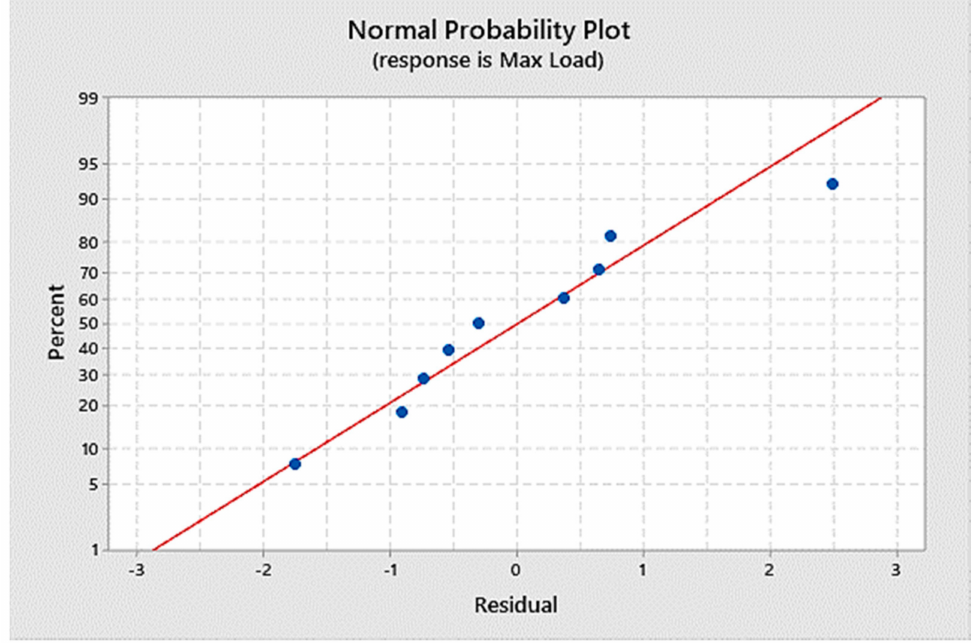
Figure 6. Normal probability plot as the response of the maximum Load.